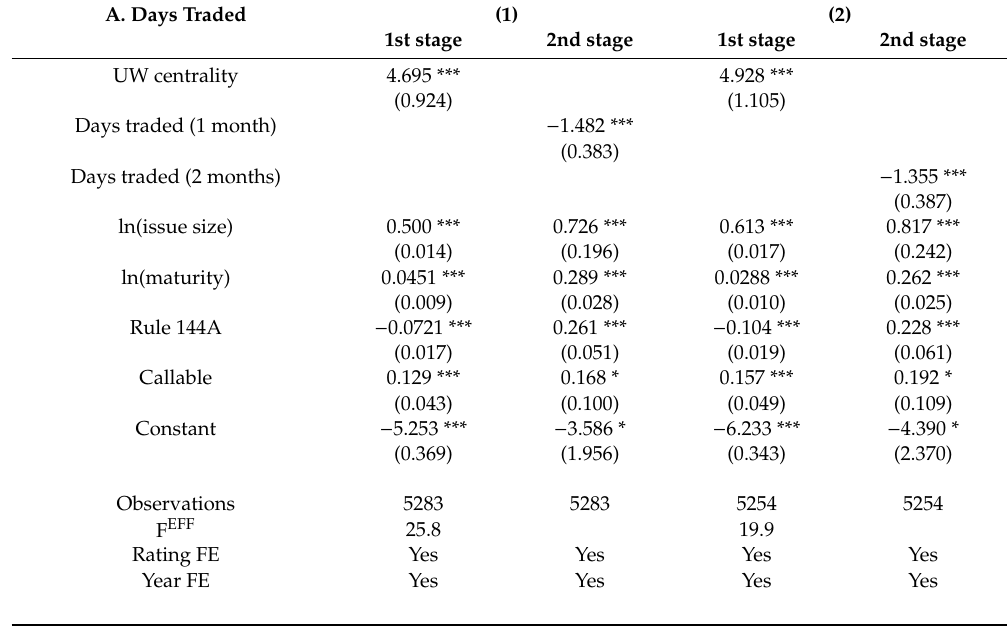
Table 4. IV Regressions for O ff ering Yield